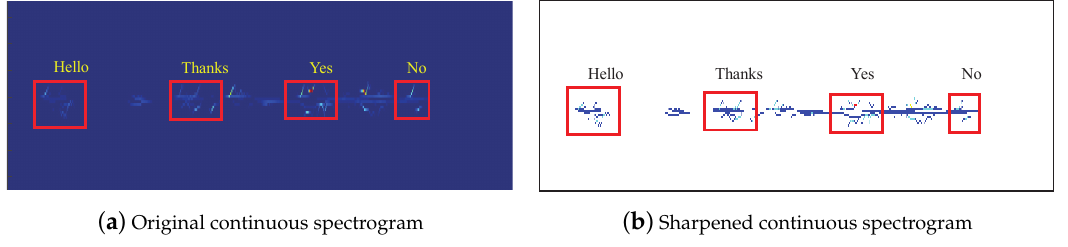
Figure 3. The spectrograms of continuous